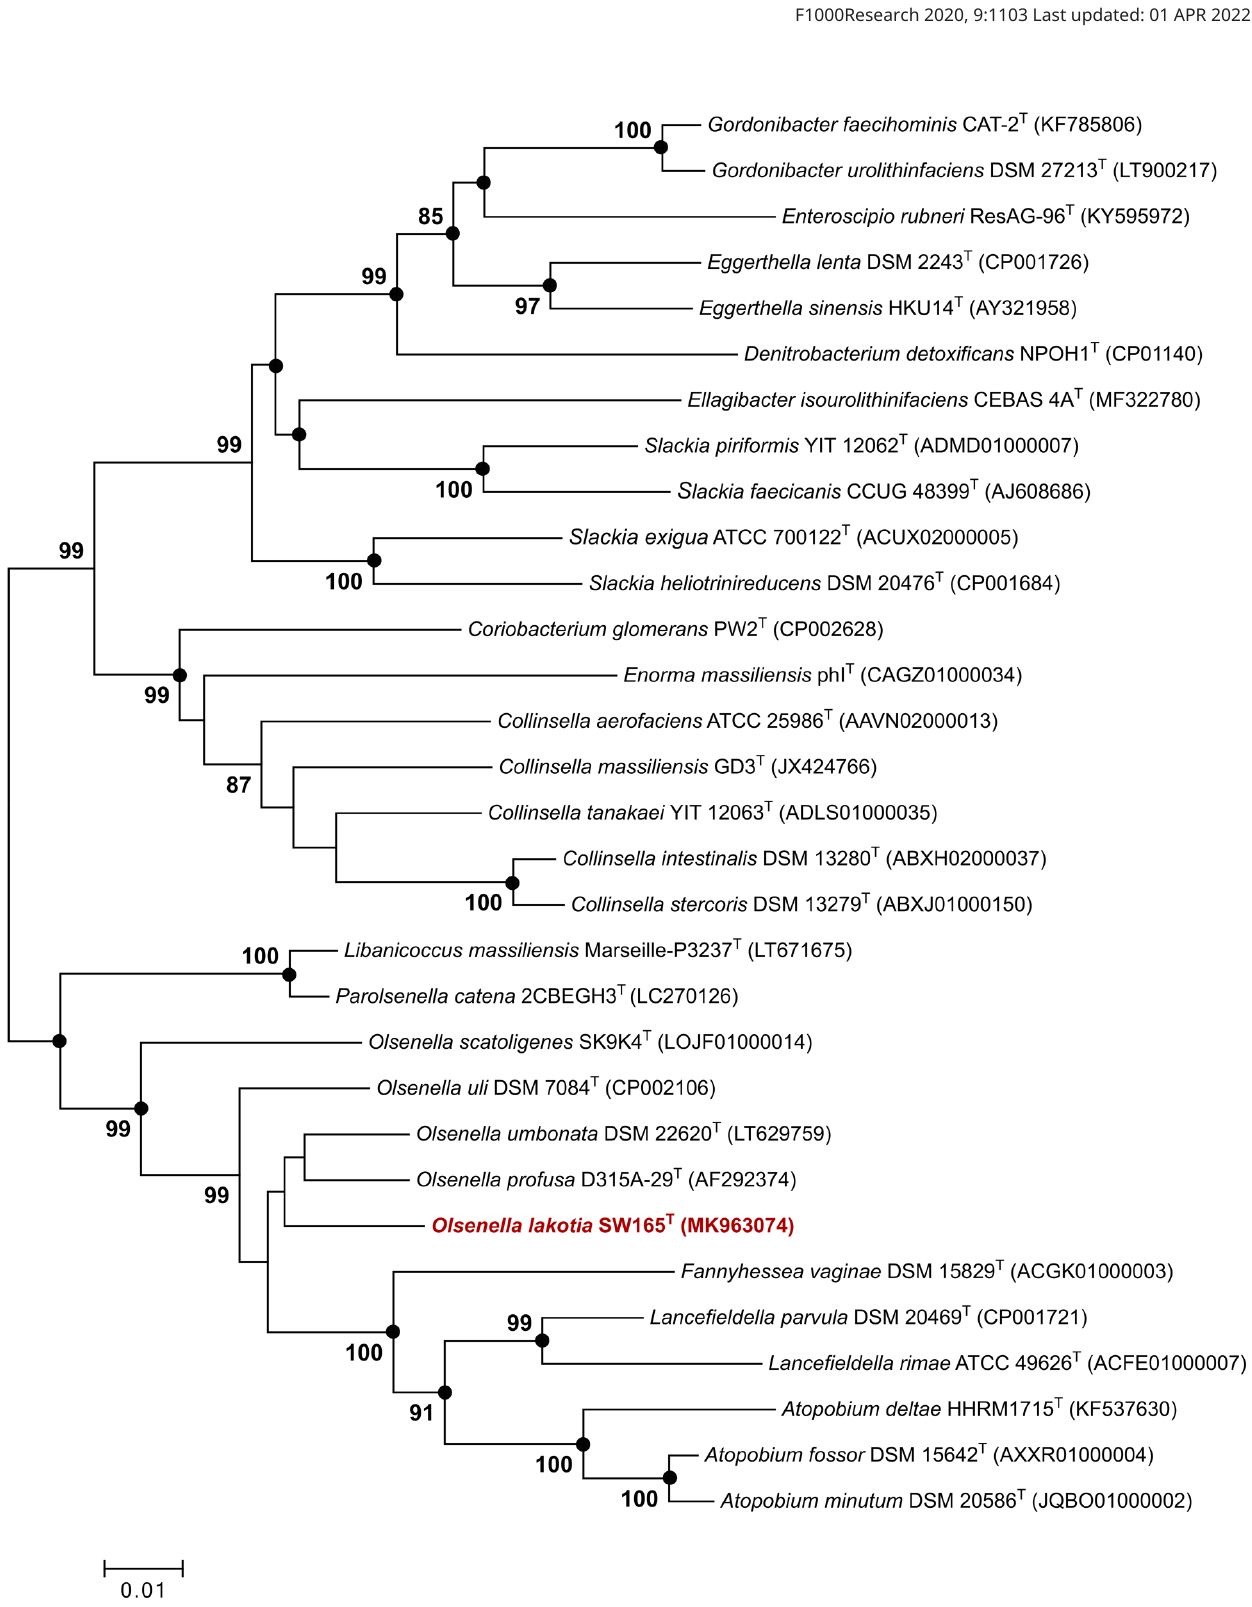
Figure 1. 16S rRNA based neighbor-joining tree of SW165 T and its neighbors. Tree shows phylogenetic position of Olsenella lakotia DSM 107283 T and closely related species in the family Atopobiaceae . GenBank accession numbers of the 16S rRNA gene sequences are given in parentheses. Black circles indicate that the corresponding branches were also recovered both by maximum-likelihood and maximum parsimony methods. Bootstrap values (based on 1000 replications) greater than or equal to 70% are shown in percentages at each node. Bar, 0.01 substitutions per nucleotide